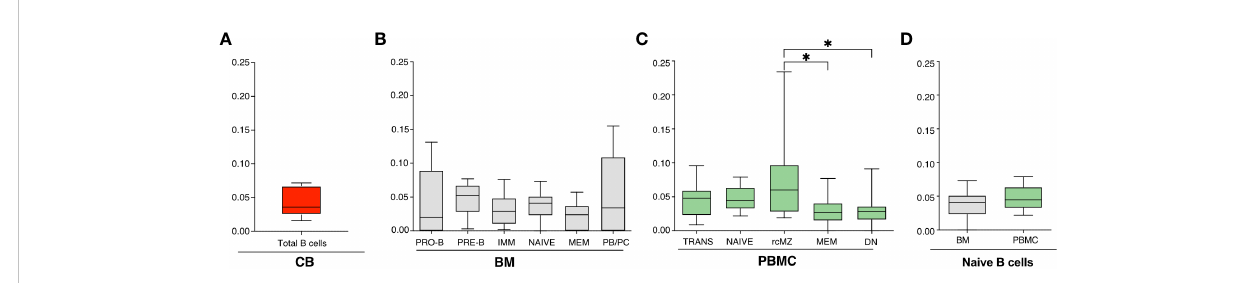
FIGURE 1 (A-C) Frequencies of CLL-SLS resembling standard stereotyped CLL BCRs identi fi ed in: (A) CB B cells (n=5); (B) BM B cell subsets (n=11); and (C) PBMC B cell populations (n=16). Statistical analyses were calculated with Kruskal-Wallis test. (D) Comparison of CLL-SLS in naïve B cells from BM and PBMC. Bars display minimum and maximum values. * p ≤